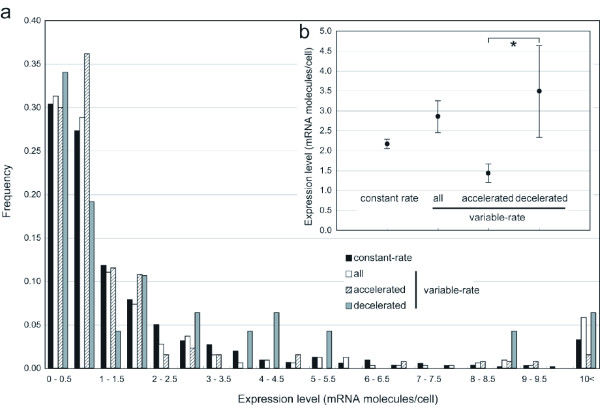
Relationship between the changes in rate of protein evolution and mRNA expression levels. (a) Histogram showing the distribution of mRNA expression levels (mRNA molecules/cell) for the genes with constant evolutionary rates and the three groups of the genes with evolutionary rate changes. (b) The means of mRNA expression levels with standard errors are shown. Statistically significant differences in mRNA expression level between rate-accelerated and rate-decelerated genes are indicated by an asterisk (*: P < 0.05), when we limited the rate variations to those occurred in the lineages leading to S. cerevisiae after the divergence from S. mikatae.